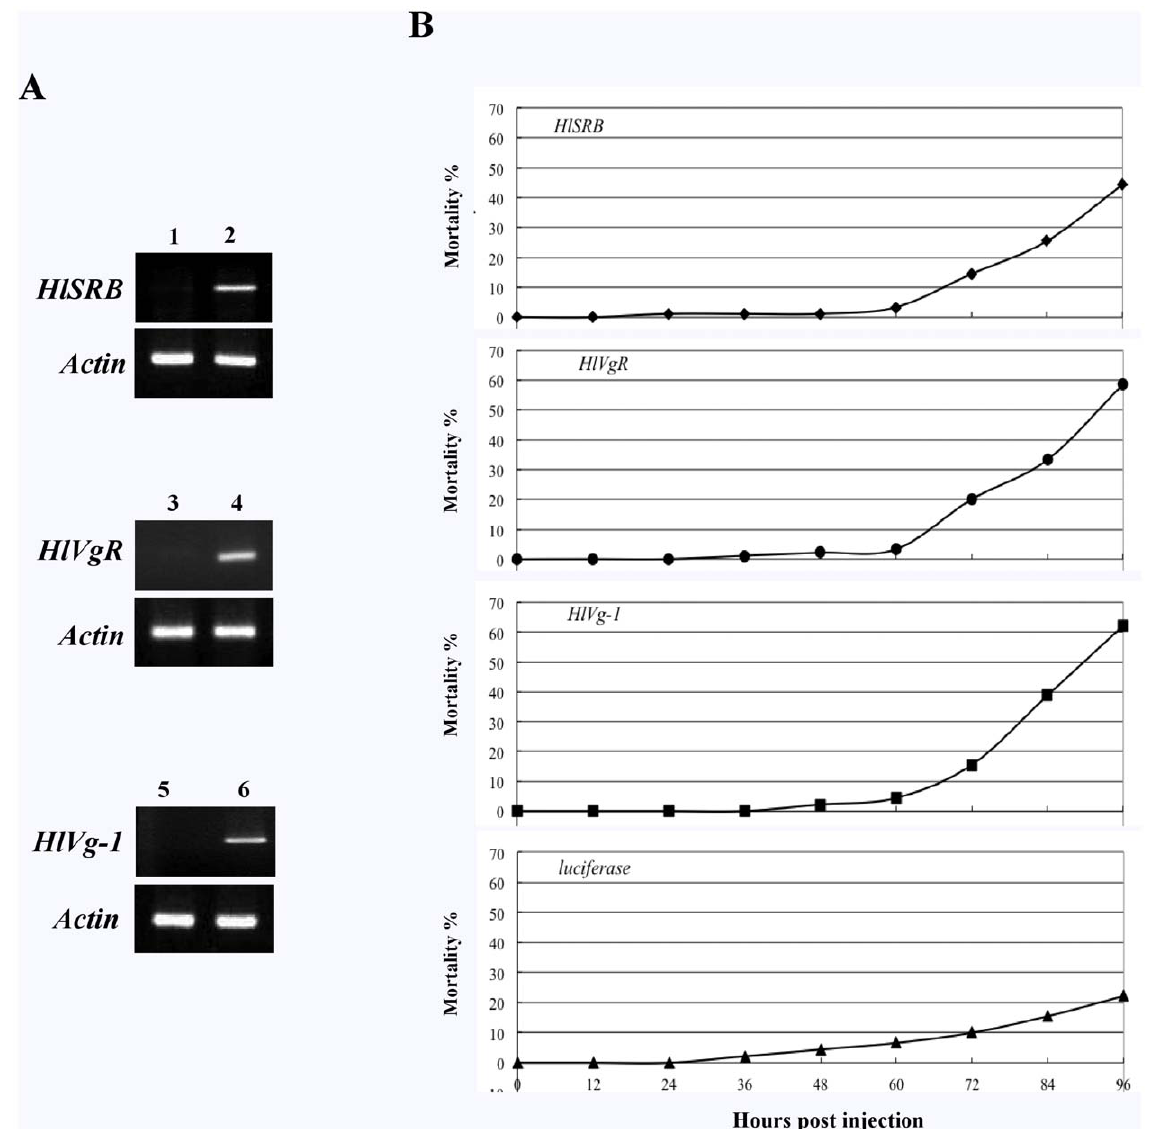
Figure 1. Gene silencing and mortality rate of H.longicornis 96 hours after a single dsRNA injection. dsRNA complementary to HlSRB , HlVgR , and HlVg-1 was injected into H. longicornis adult females. The injected ticks were allowed to rest at 25 u C in an incubator for four days to check mortality rates and gene silencing. RT-PCR analysis (A). PCR was performed using cDNA synthesized from three ticks injected with HlSRB , HlVgR , HlVg- 1 , or luc dsRNA with primer sets specific to HlSRB , HlVgR , HlVg-1 , and the b -actin gene. Lane 1, HlSRB dsRNA-injected ticks; lanes 2, 4, and 6, luc dsRNA- injected ticks; lane 3, HlVgR dsRNA-injected ticks; lane 5, HlVg-1 dsRNA-injected ticks. Mortality rates (B). Each panel represents treatment with one gene-specific dsRNA. Mortality rates were calculated by the percentage of number of dead ticks to the number of ticks used at the beginning of experiment in a different time course. HlSRB , HlSRB dsRNA-injected ticks; HlVgR , HlVgR dsRNA-injected ticks; HlVg-1 , HlVg-1 dsRNA-injected ticks; luciferase , luciferase dsRNA-injected